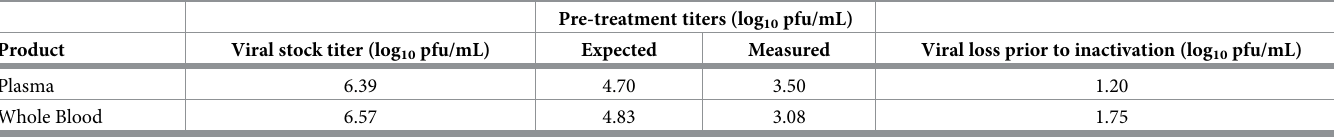
Table 1. Stock and pre-treatment viral titers.